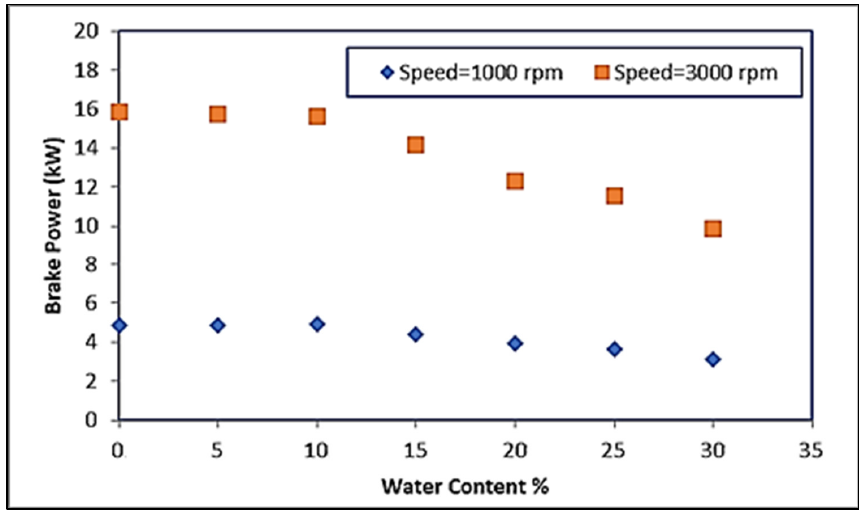
Figure 9. The fluctuation of BP (kW) as a function of water concentration and two constant engine speeds, 1000 and 3000 rpm.